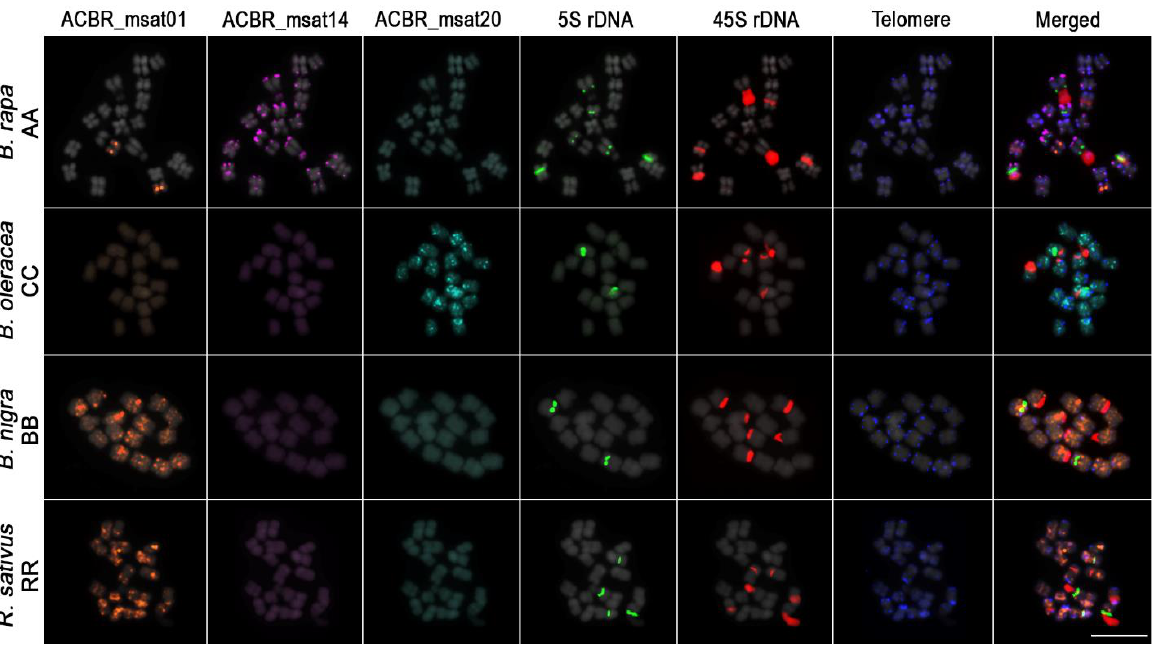
Figure 2. FISH analysis of ACBR_msat01, ACBR_msat14, and ACBR_msat20 in the four diploid genomes. ACBR_msat14, and ACBR_msat20 were exclusively detected in B. rapa and B. oleracea genomes, respectively. ACBR_msat01 was detected in both B. nigra and R. sativus genomes including one pair of B. rapa chromosomes. Scale bar = 10 μm.